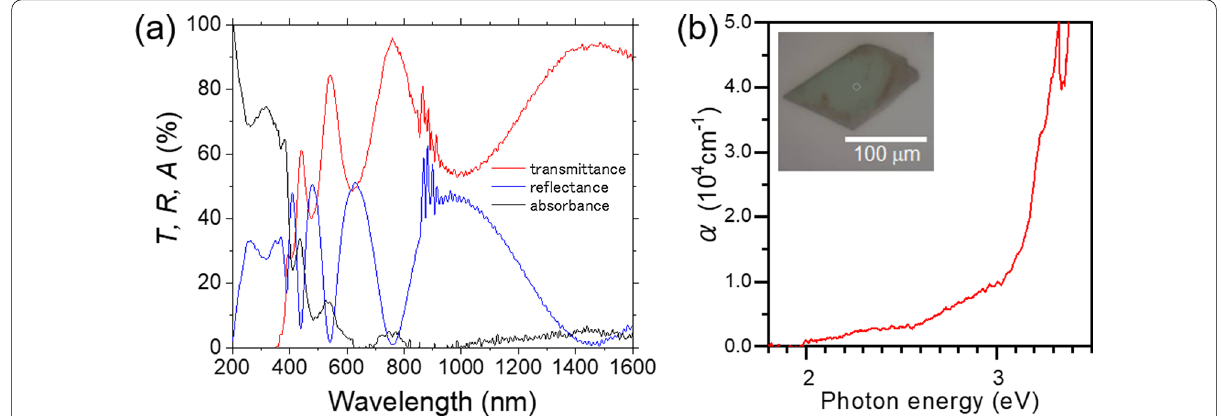
Fig. 1 a Transmittance, reflectance, absorbance spectra and b absorption coefficient of GaSe flake. Inset: optical microscope image of GaSe